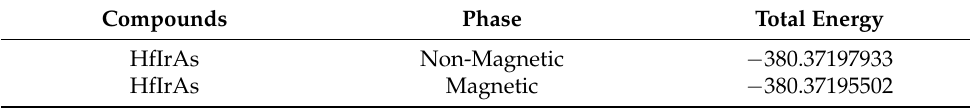
Table 1. Table of magnetic phases of HfIrAs. Compounds Phase Total Energy HfIrAs Non-Magnetic − 380.37197933 HfIrAs Magnetic −